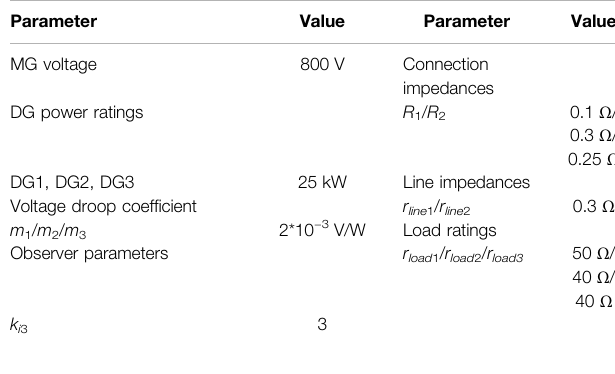
TABLE 1 | Control and system